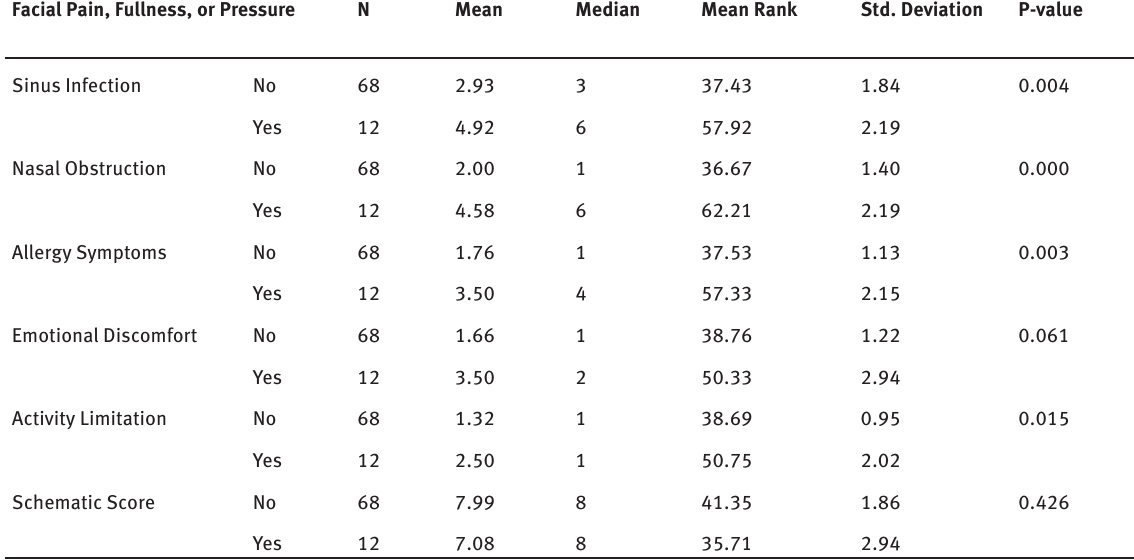
Table 4: Comparison of quality of life scores between people with facial pain, fullness, or pressure and those no -facial pain, fullness, or pressure using the Nonparametric Mann-Whitney U